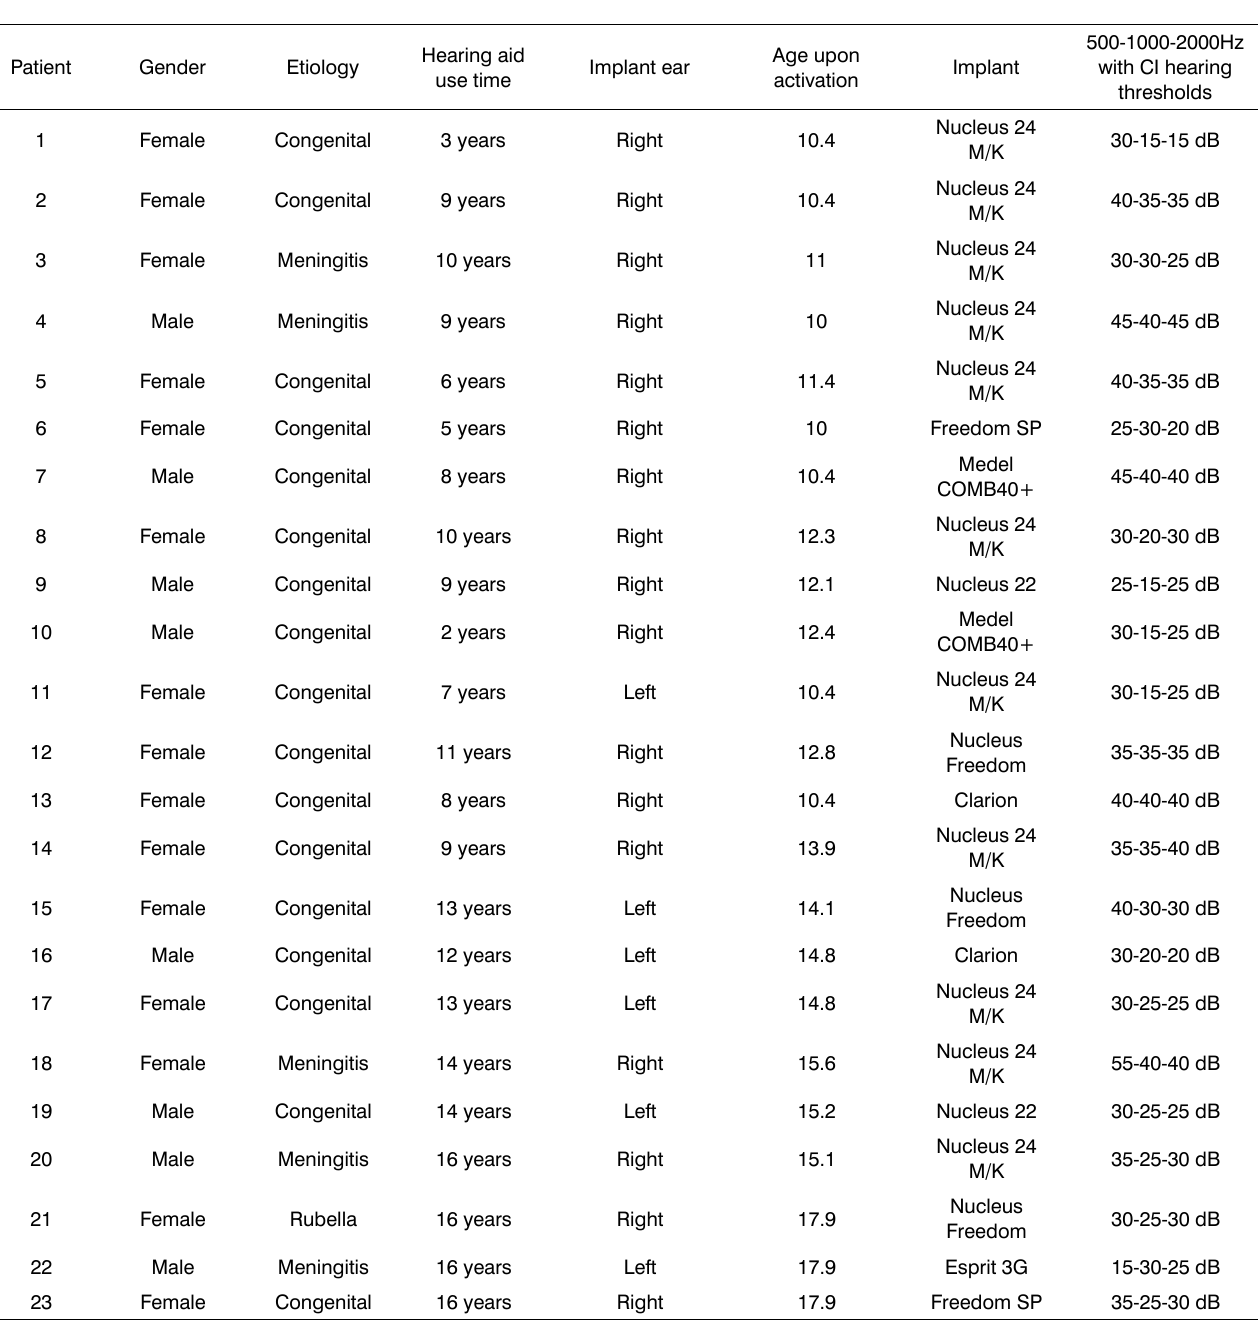
Table 1. Demographic data from the 23 patients in the